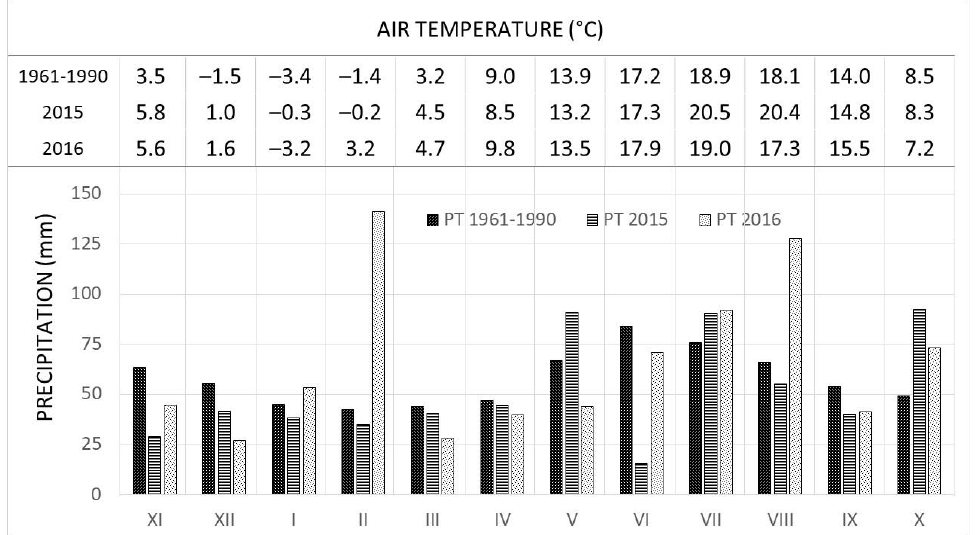
Figure 1. Monthly means of the air temperature and precipitation totals (PT) in hydrological years 2015 and 2016 in Bienska Valley (450 a.s.l.) compared with the long-term mean (normal) of 1961 –